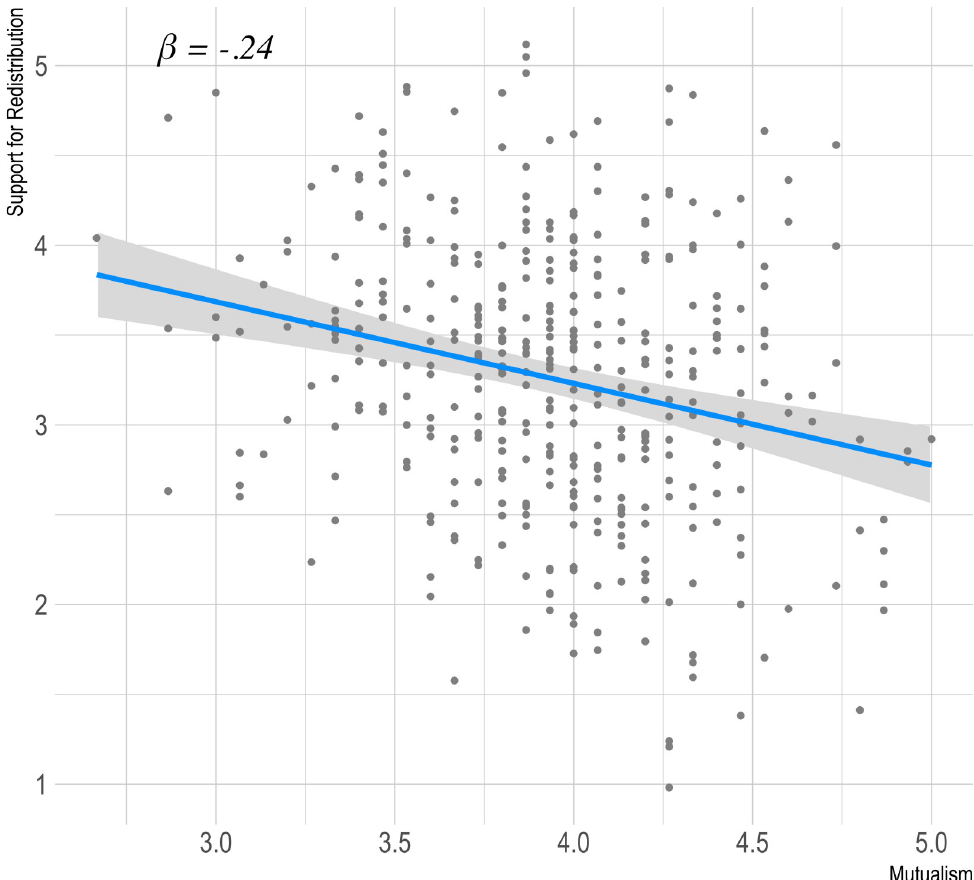
Fig 3. Graph showing effect of mutualism on support for redistribution in study